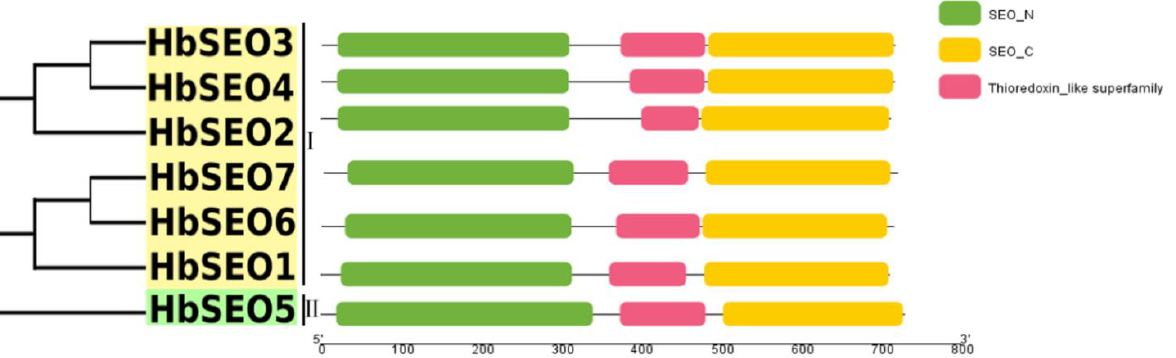
Figure 1. Conserved domains of HbSEO proteins. Different colors represent different domains, green represents SEO_N (SEO N-terminal domain), pink represents SEO_C (SEO N-terminal domain), and yellow represents Thioredoxin-like super-family.